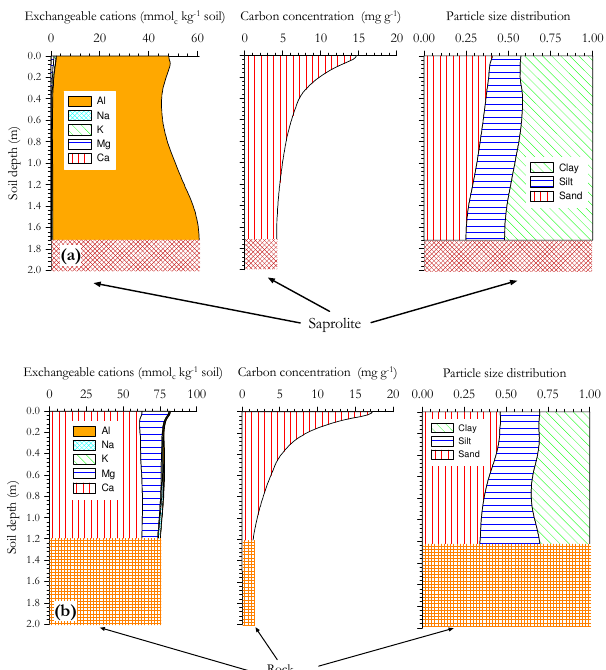
Fig. 7 Fig. 7. Profiles of exchangeable cations, soil carbon and texture for (a) a Haplic Cambisol (Alumic, Hyperdystric, Clayic) in south Peru (TAM-05) and (b) a Haplic Cambisol (Orthoeutric) in Ecuador